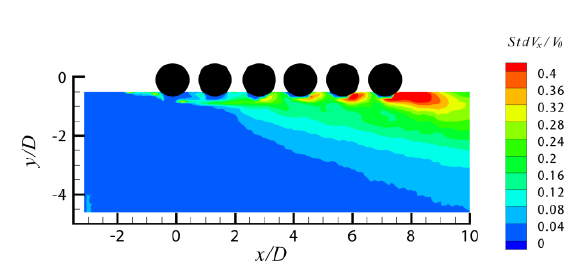
Fig. 5. Normalized mean standard deviation of streamwise velocity component contour plot for lateral region